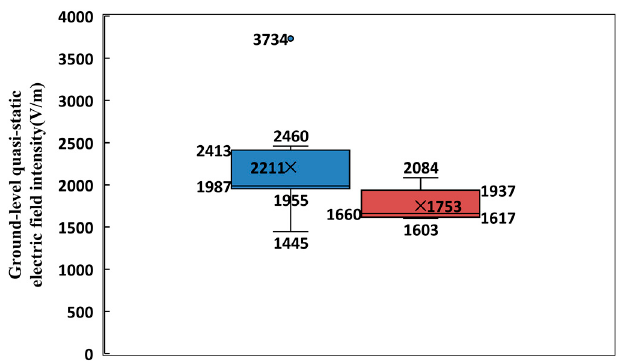
Figure 6. Statistical chart of ground-level quasi-static electric field intensity during rocket launching. The blue part corresponds to the single initial process form, and the red part corresponds to the multiple initial process form.